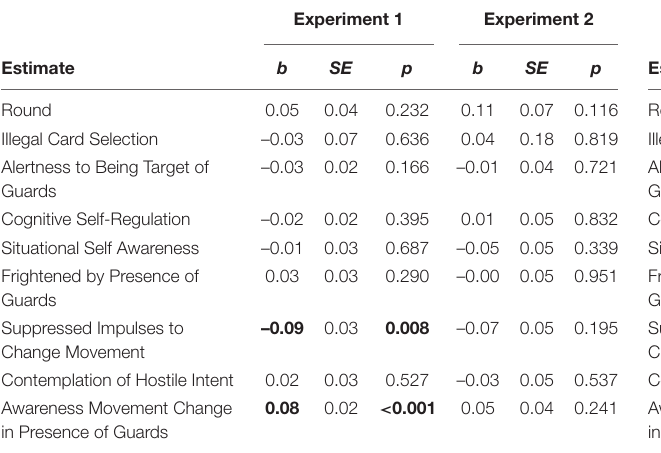
TABLE 3 | Regression beta, SE, and P -values for speed variation as dependent